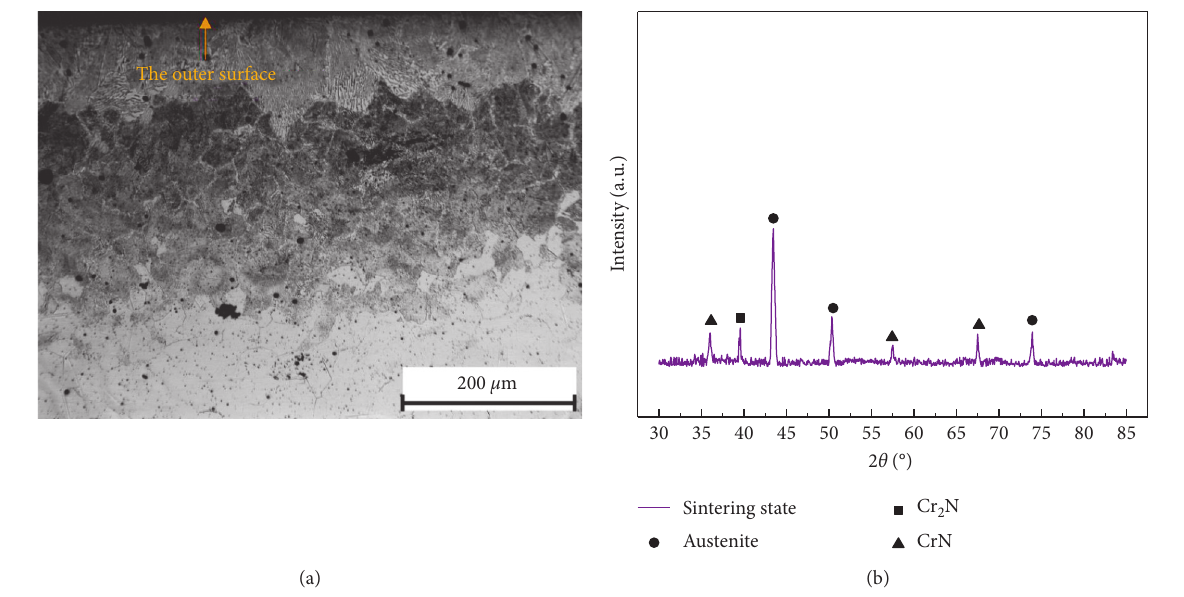
Figure 2: (a) Metallographic structure of the sintered alloy and (b) its XRD